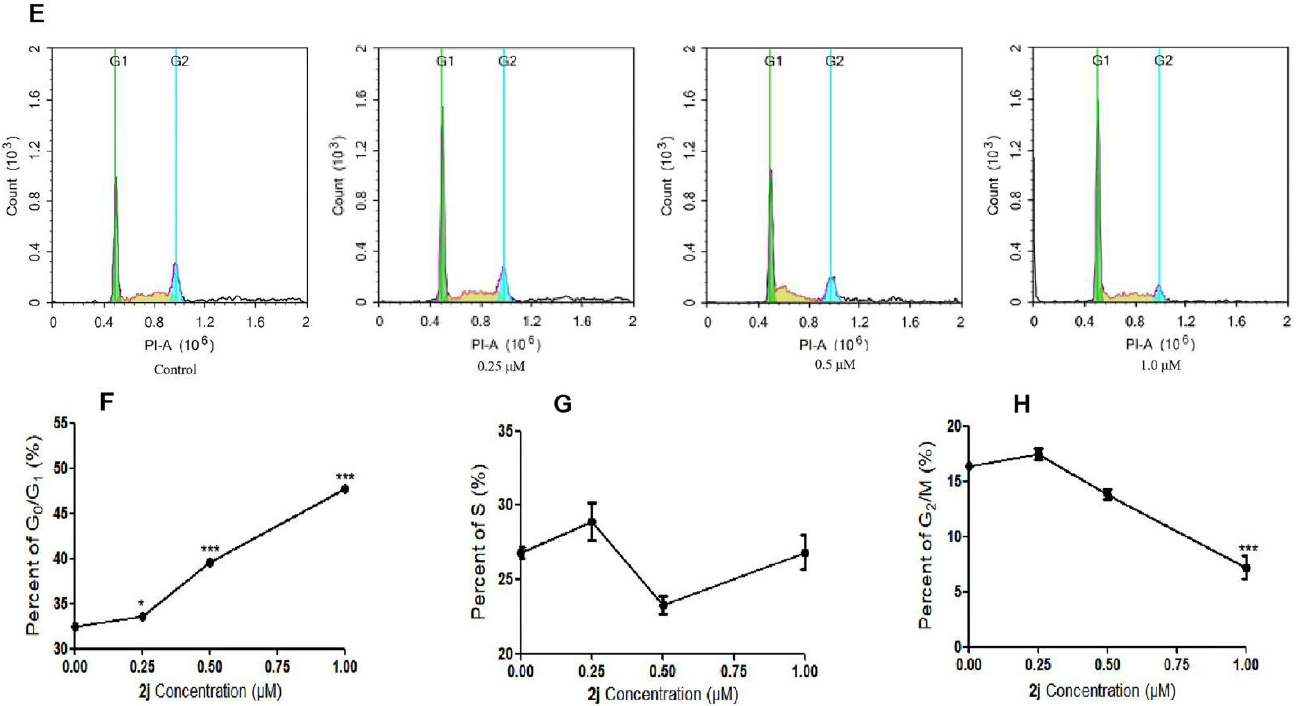
Figure 4. Effects of compound 2j on Jurkat Clone E6-1 and THP-1 cell-cycle. ( A ) The cell-cycle distribution of Jurkat Clone E6-1 using flow cytometry. ( B ) The percentage of Jurkat Clone E6-1 cells in the G 0 /G 1 phase. ( C ) The percentage of Jurkat Clone E6-1 cells in the S phase. ( D ) The percentage of Jurkat Clone E6-1 cells in the G 2 /M phase. ( E ) The cell-cycle distribution of THP-1 using flow cytometry. ( F ) The percentage of THP-1 cells in the G 0 /G 1 phase. ( G ) The percentage of THP-1 cells in the S phase. ( H ) The percentage of THP-1 cells in the G 2 /M phase. All data are presented as means ± SD ( n = 3); * p < 0.05 and *** p < 0.001 vs. the control